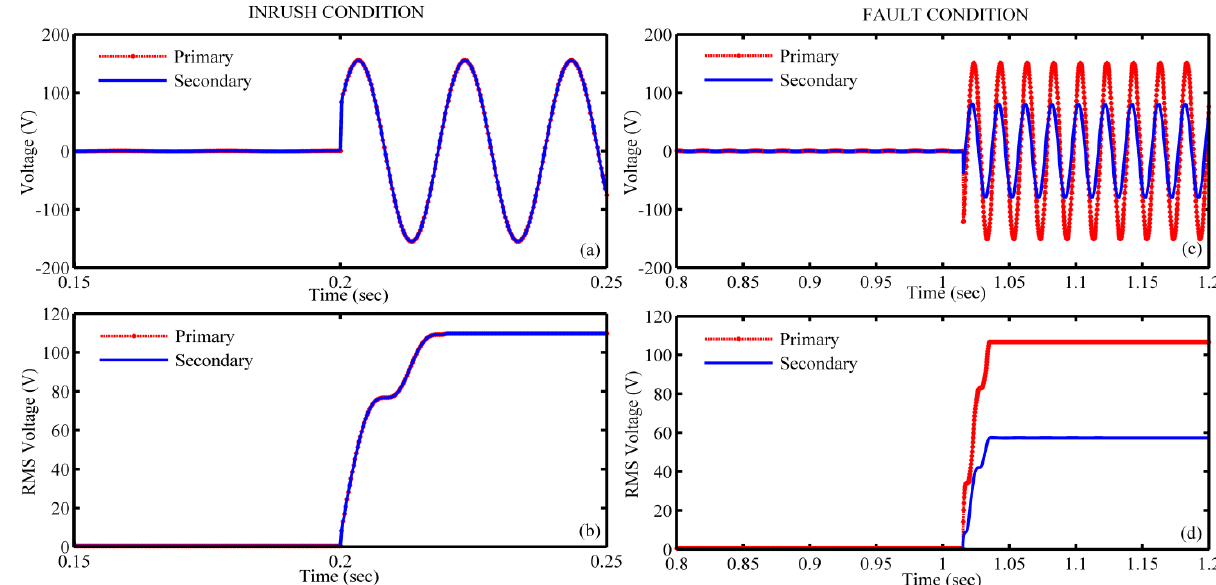
Fig. 6. (a) Voltage waveform during inrush, (b) RMS value of voltages during inrush, (c) Voltage waveform during fault, (d) RMS value of voltages during fault.